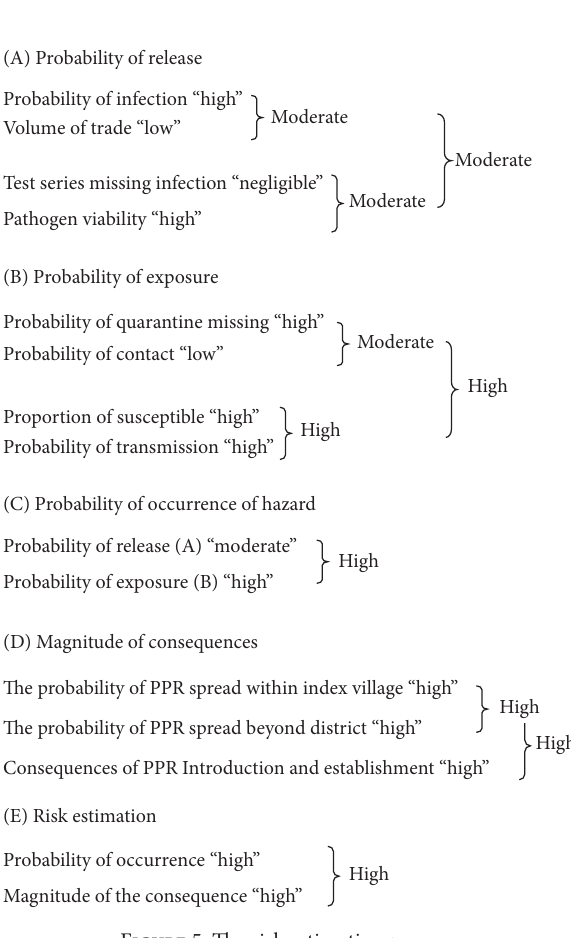
Figure 5: The risk estimation